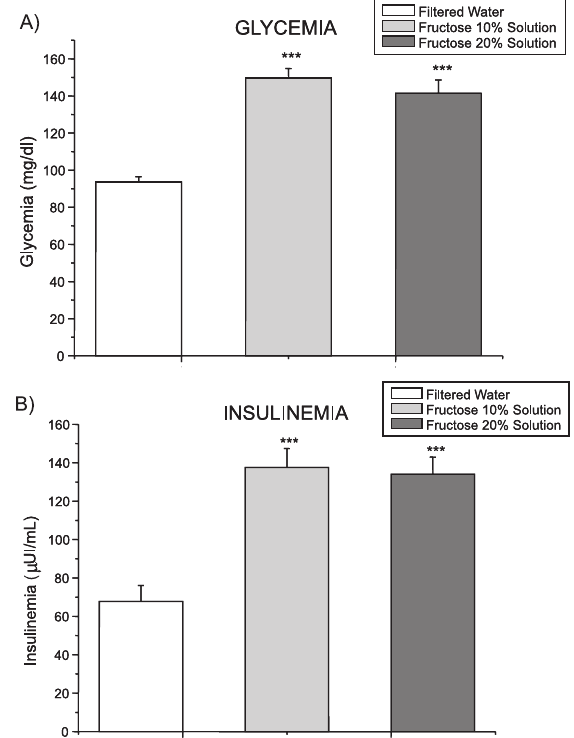
Figure 1 - Effects on glycemia (a) and insulinemia (b) of filtered water, 10% fructose solution, or 20% fructose solution on animals treated for 2 months.. Results expressed as mean ± SEM; *** = P < .001 compared to controls.